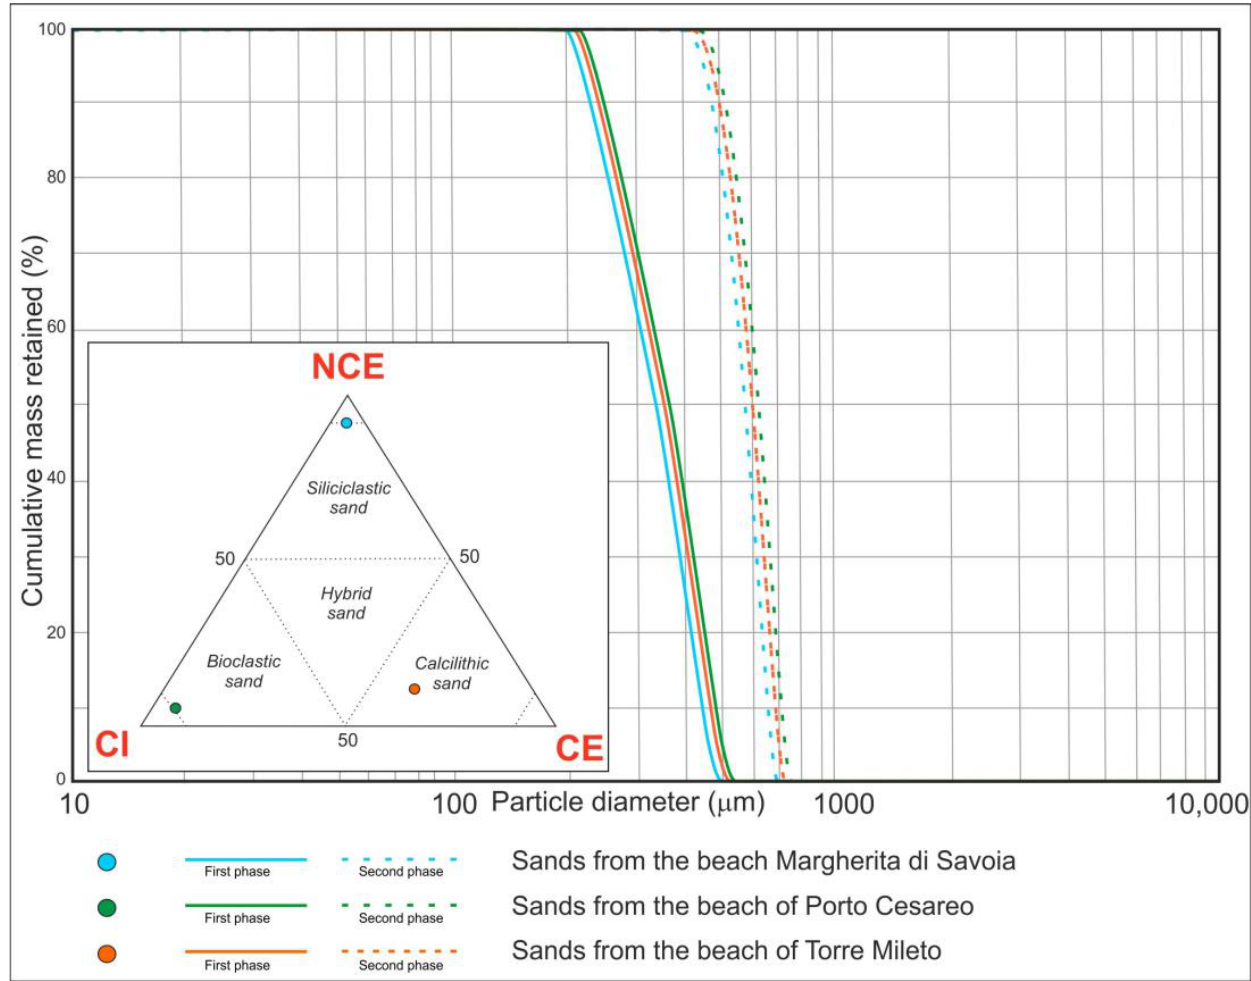
Figure 3. Grain size and compositional features of the sand used in the two-phase experiment. The cumulative curves show the granulometric range of the three kinds of sands for the first (continue lines) and second (dotted lines) phases. Note that the sands of the second phase were slightly coarser than those of the first phase. Bottom left: the composition of the sands used in both phases. They fell in the distinct fields of the Zuffa classification [32,33].